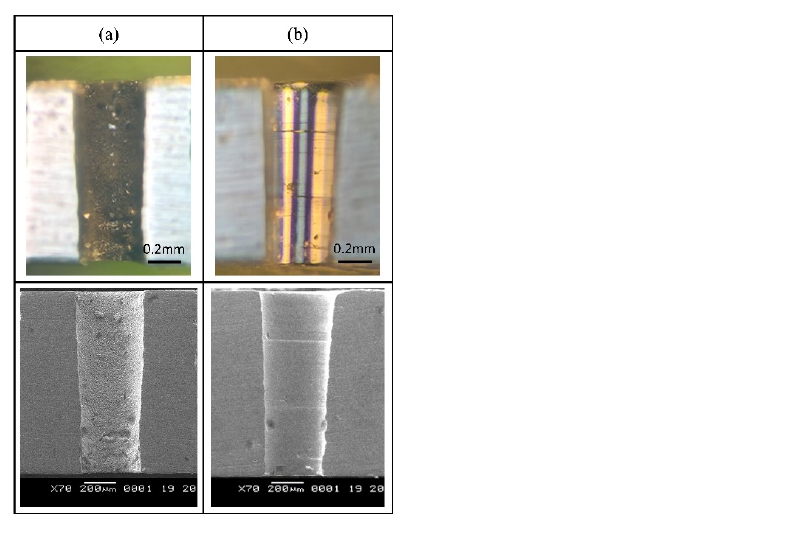
Figure 14. Photo and SEM images of the micro hole before and after polishing. ( a ) Before polishing. ( b ) After polishing.